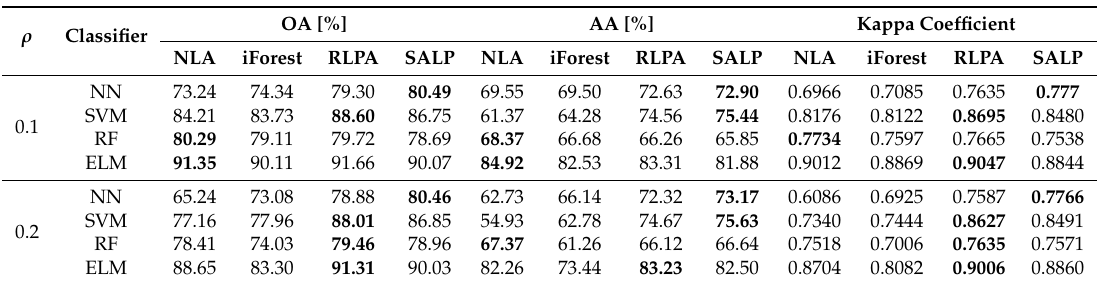
Table 1. Comparisons of baselines and SALP over four typical classifiers with the “random” Setting on the Indian Pines dataset. The best results are